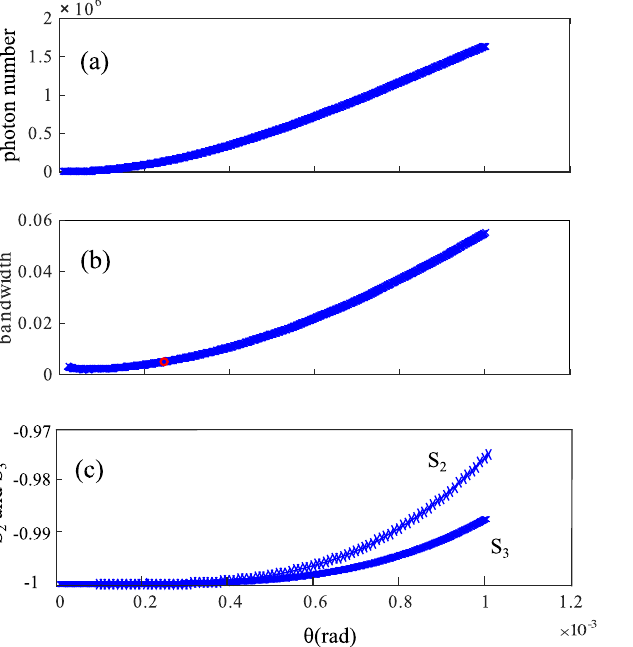
FIG. 7. ELI-NP case (beam 2): (a) photon number, (b) relative bandwidth, and (c) Stokes parameters S 2 and S 3 for gamma rays at 2 MeV, linear and circular laser polarizations.